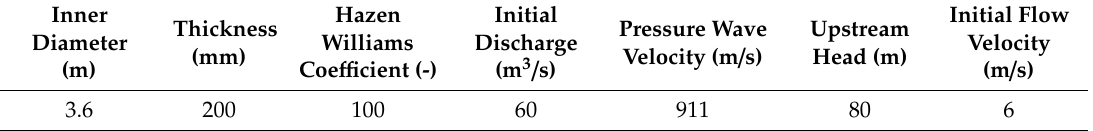
Table 2. Geometric and hydraulic characteristics of the